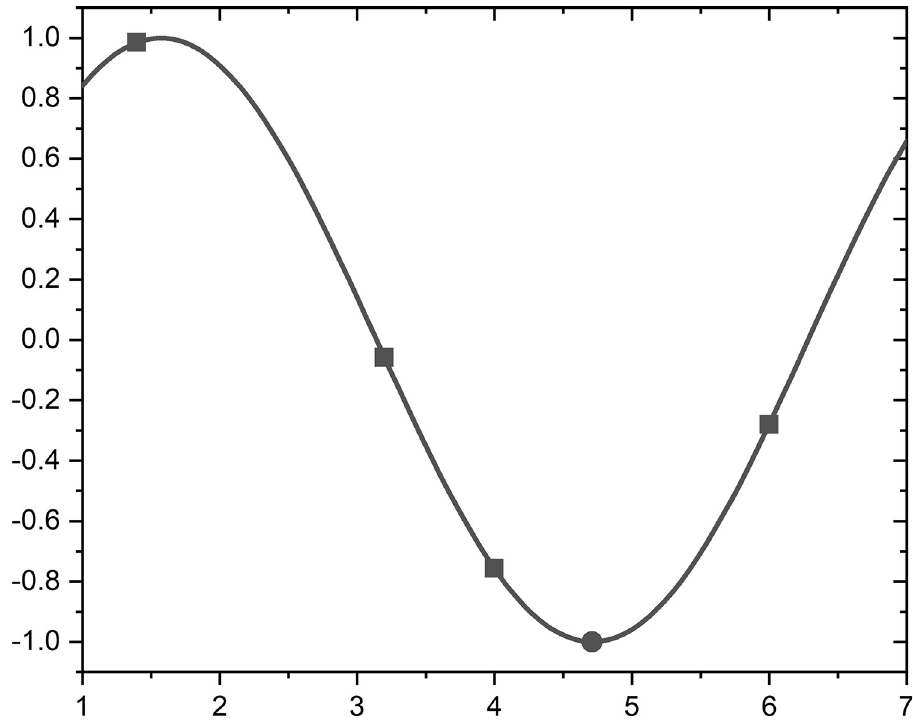
Fig 3. Example of